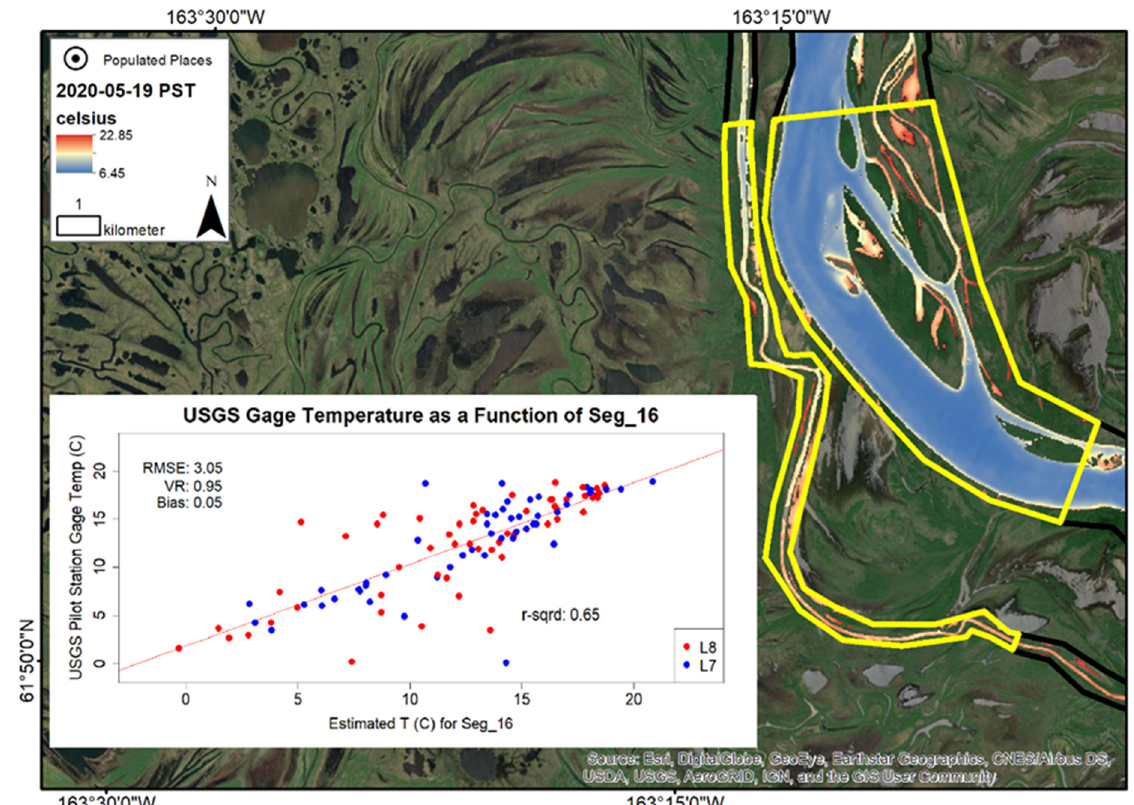
Figure A14. Segment 16 is the first segment fully downstream from the Pilot Station USGS streamgage. The river occupies a single channel interspersed with small islands. These islands have remained relatively undisturbed as indicated by dense shrub cover. Historically these islands were mapped as gravel bars. This suggests that the river channel is migrating to the west as it erodes into the long cut bank. Lowlands and wetlands surround the Yukon River. A portion of the segment is made up of Driftwood Slough as it courses along to the west of the Yukon River. Correlation between pST and measured water temperature is good (RMSE = 3.05 °C, r 2 = 0.65) but less than preceding river segments; pST coverage is 100% with no NoData gaps.